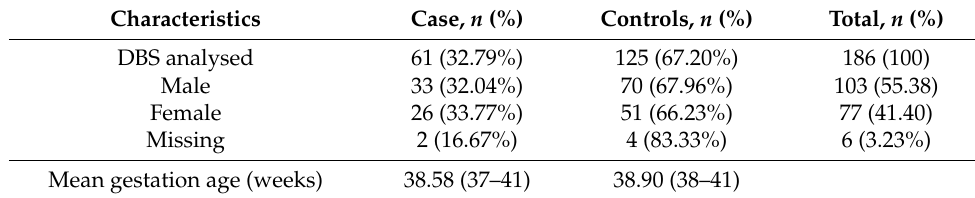
Table 1. Characteristics of cases and controls.